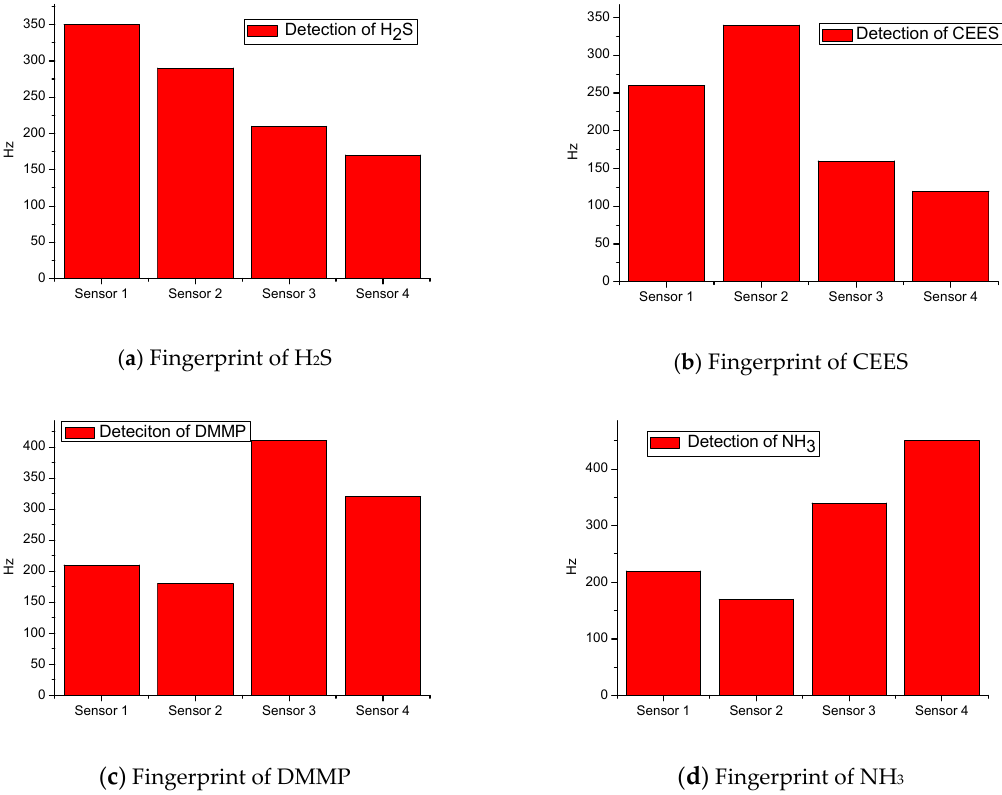
Figure 8. Fingerprints of the four kinds of gases detected by SAW sensor array .